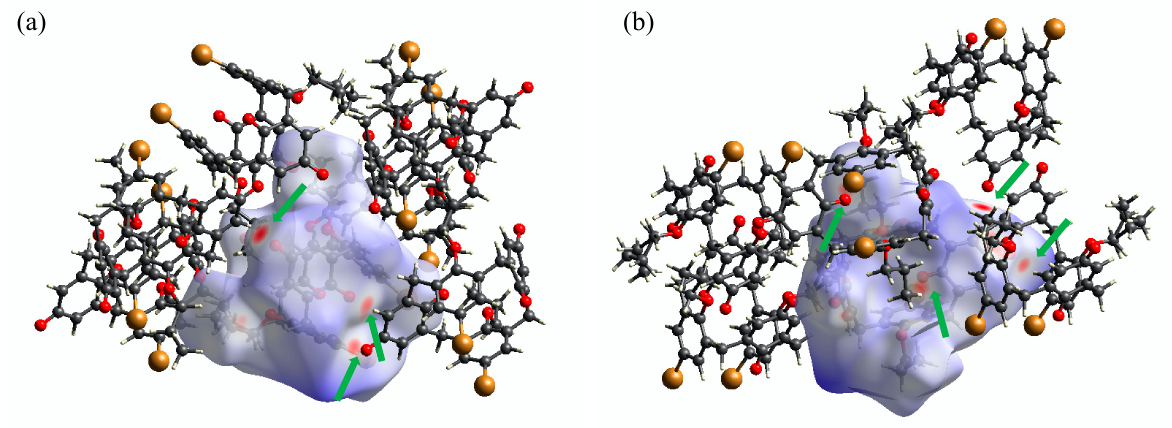
Figure 9. The d norm surfaces for 1a ( a ) and 1b ( b ) showing C–H ··· O interactions (red spots with green